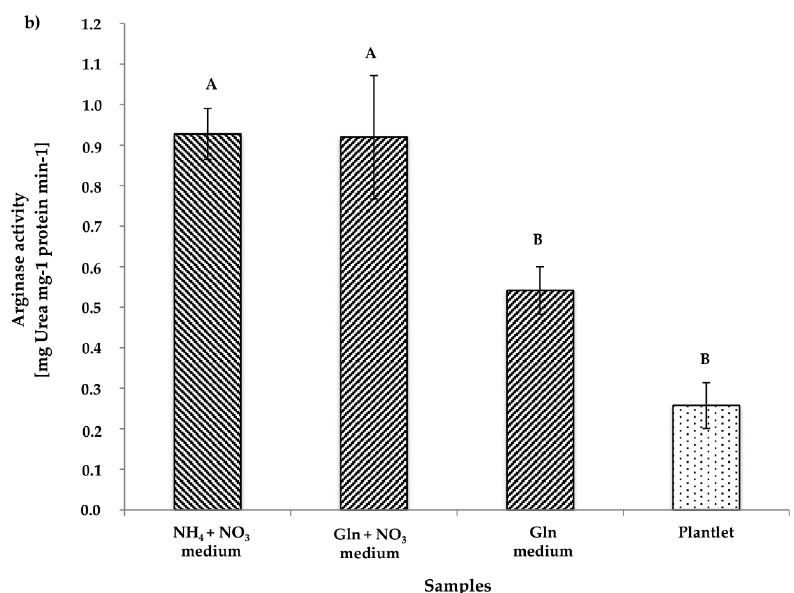
Figure 8. Arginase activity of PEMs and mature somatic embryos (MSE). ( a ) arginase activity of PEMs after 4 days (PEM 4d) and after 10 days (PEM 10d) on standard medium, NH 4 + NO 3 medium, Gln + NO 3 medium and Gln medium in comparison with somatic embryo-derived plantlets run as control; ( b ) arginase activity of mature somatic embryos generated on NH 4 + NO 3 medium, Gln + NO 3 medium and Gln medium in comparison with two-month-old somatic embryo-derived plantlets. Bars indicate standard errors. Different letters above the columns indicate significant differences based on the Tukey-Kramer HSD test, p ≤ 0.05.